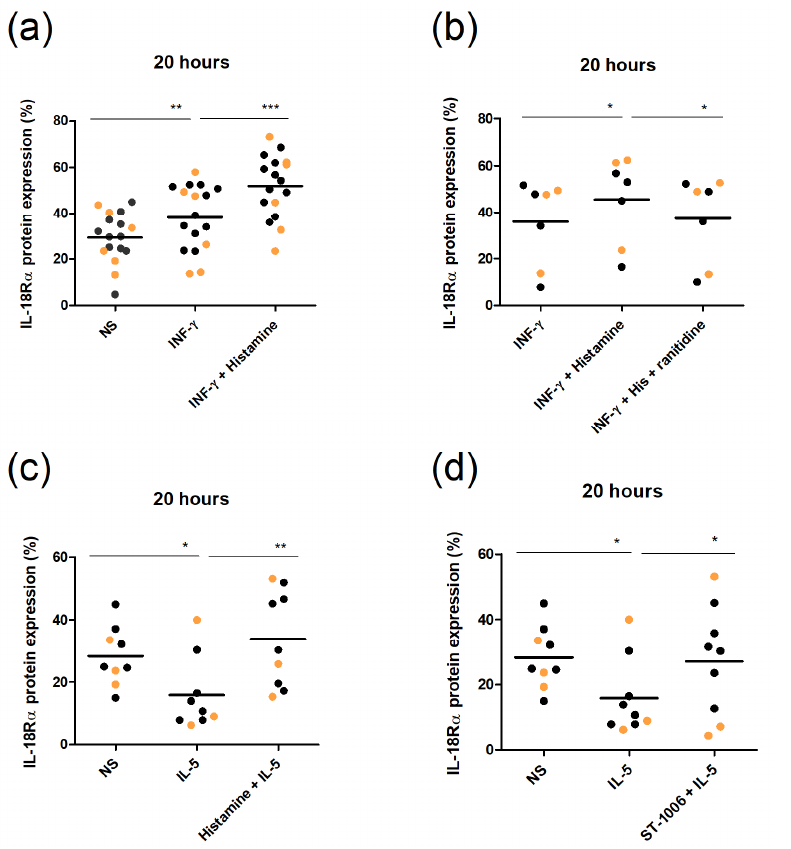
Figure 5. Histamine potentiates the IFN-γ-mediated IL-18Rα protein induction via H 2 R and abolishes the IL-5-mediated downregulation via H 4 R in eosinophils. The expression level of the IL-18Rα was measured by flow cytometry. ( a , b ) Purified eosinophils from AD patients (black) and healthy controls (orange) were stimulated with histamine (10 μmol/L), INF-γ (10 ng/mL), or the combination of both stimuli for 20 h. The H 2 R antagonist ranitidine (10 μmol/L) was added 30 min before histamine. ( c , d ) Purified eosinophils from AD patients (black) and healthy controls (orange) were stimulated with histamine (10 μmol/L), IL-5 (10 ng/mL), or the combination of IL-5 with histamine and H 4 R agonist ST-1006 (10 μmol/L), respectively, for 20 h. For statistical analysis, a Wilcoxon signed rank test was applied. * p -value < 0.05; ** p -value < 0.1; *** p -value < 0.01; NS—not stimu-